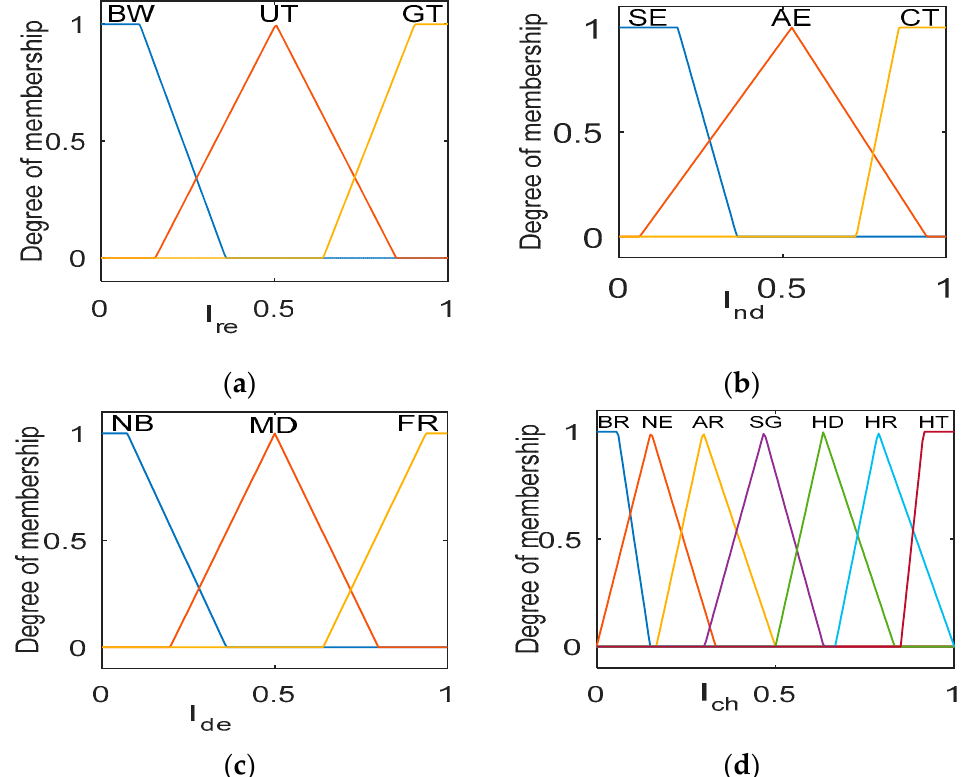
Figure 2. Membership function: ( a ) Residual energy ( I re ), ( b ) Node density ( I nd ), ( c ) Distance to edge node ( I de ), and ( d ) Probability chance ( I ch